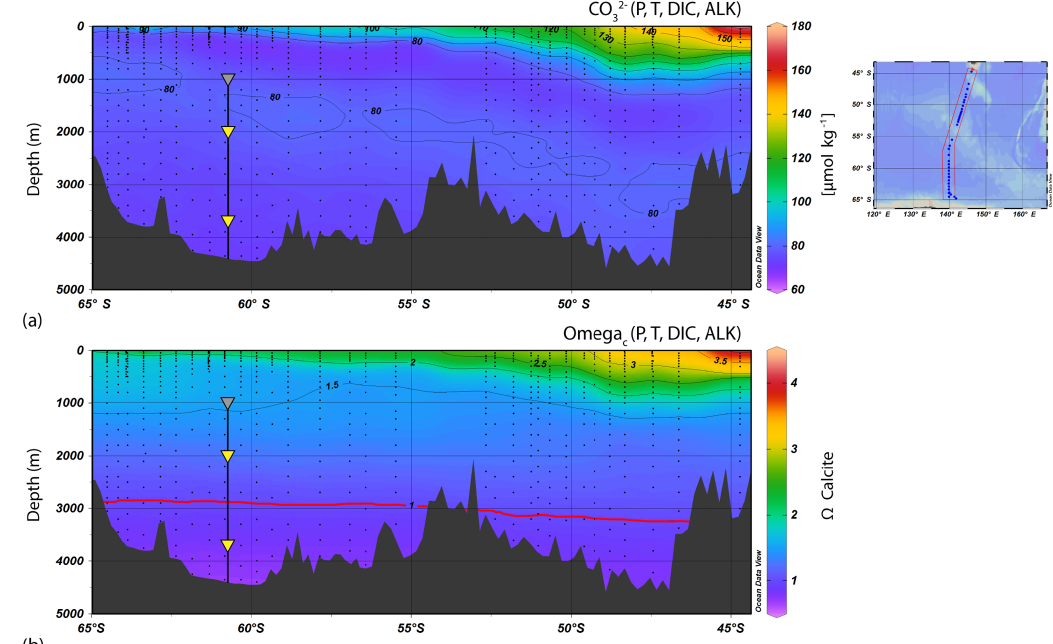
Figure 3. Cross section of the mooring location in comparison to regional sea-floor bathymetry, carbonate concentrations [CO 2 − saturation ( (cid:127) calcite ) for WOCE transect SR03 2001 from Bostock et al. (2011), who calculated them from the dissolved inorganic carbon (DIC) and alkalinity in the CARINA database (CARINA group, 2011). The location of the transects is shown on the map on the right top. The (cid:127) calcite = 1 contour is highlighted with a red line to show the approximate depth of the CSH across the